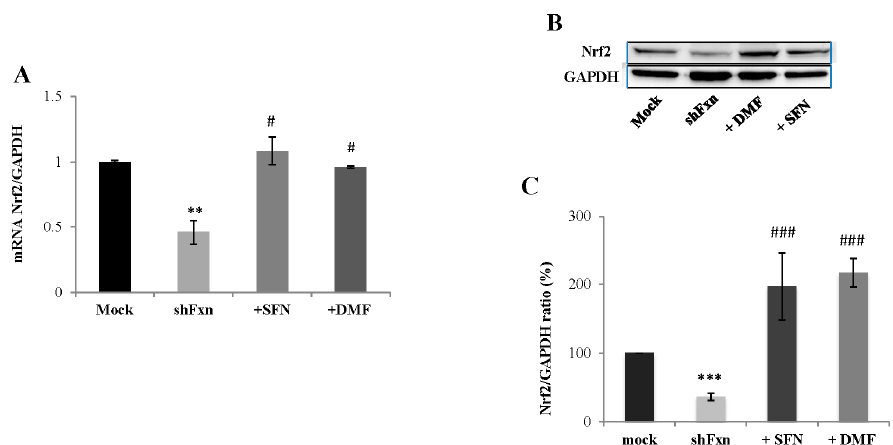
Figure 1. Nrf2-inducers up-regulate the Nrf2 expression in frataxin silenced neurons (shFxn). ( A ) qRT-PCR of mRNA Nrf2 levels in shFxn and Mock after 5 µM (24 h) sulforaphane (SFN) and 30 µM (24 h) dimethyl fumarate (DMF) treatments. Glyceraldehyde 3-phosphate dehydrogenase (GAPDH) is used for normalization and relative quantification of gene expression was performed according to the 2 −ΔΔ C t method; ( B ) Representative Western blot of DMF- and SFN-treated shFxn neurons; ( C ) Densitometry of Nrf2 protein amounts analyzed by Western Blot. Values represent the mean ± SD of three independent experiments (** p < 0.01 and *** p < 0.001, with respect to Mock; # p < 0.05 and ### p < 0.001, with respect to untreated shFxn).